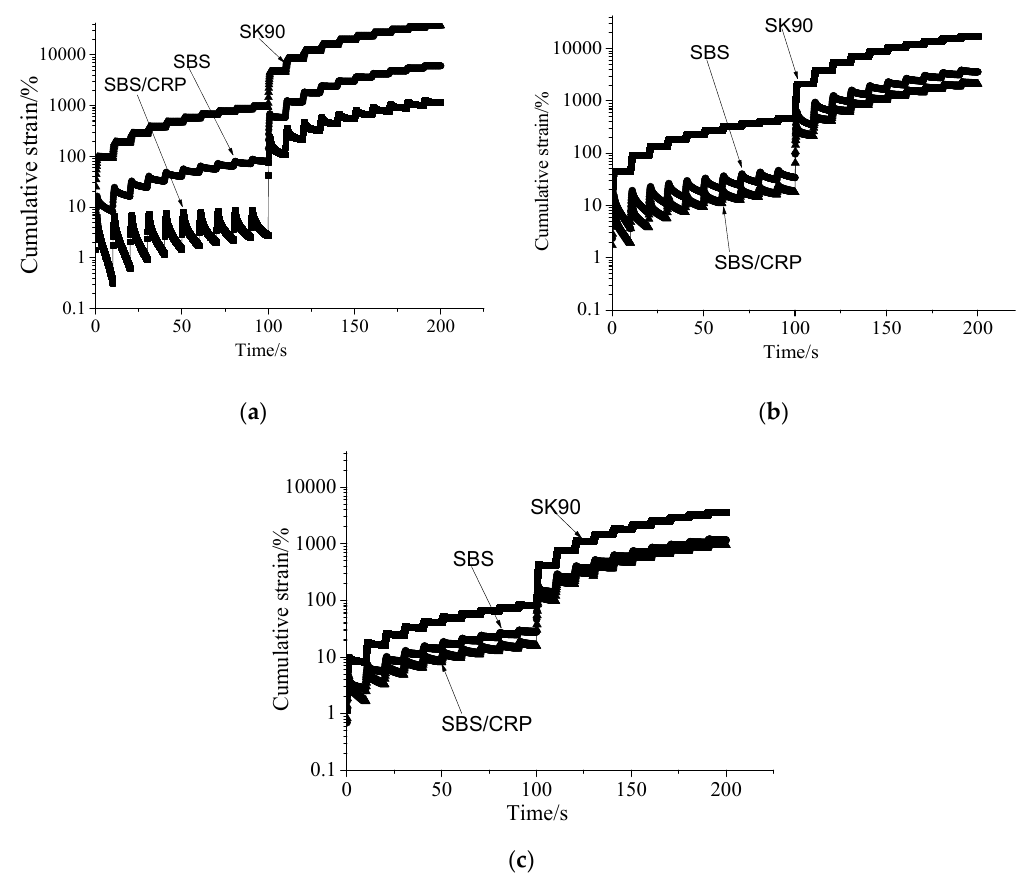
Figure 4. MSCR test curves of three asphalts at 64 ℃ under different aging conditions: ( a ) original asphalts; ( b ) asphalts after TFOT aging; ( c ) asphalts after PAV aging.